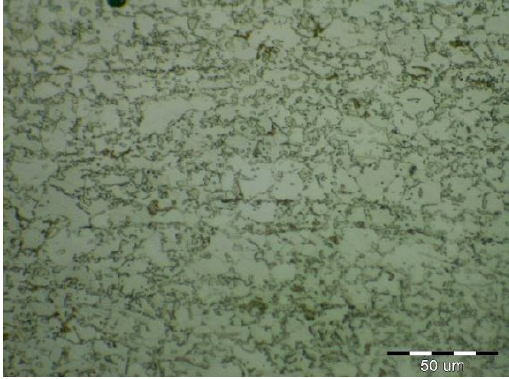
Figure 11. Macrostructure of the welded joint sample B (DP600).